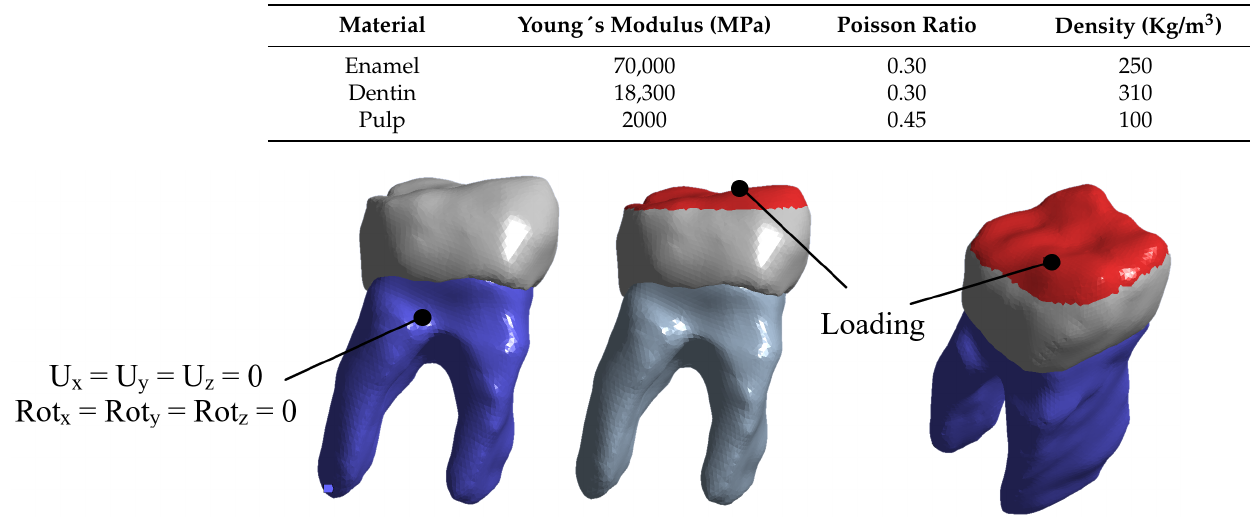
Figure 5. Biomodel of the lower right first molar. Table 1. Mechanical properties of the tooth.